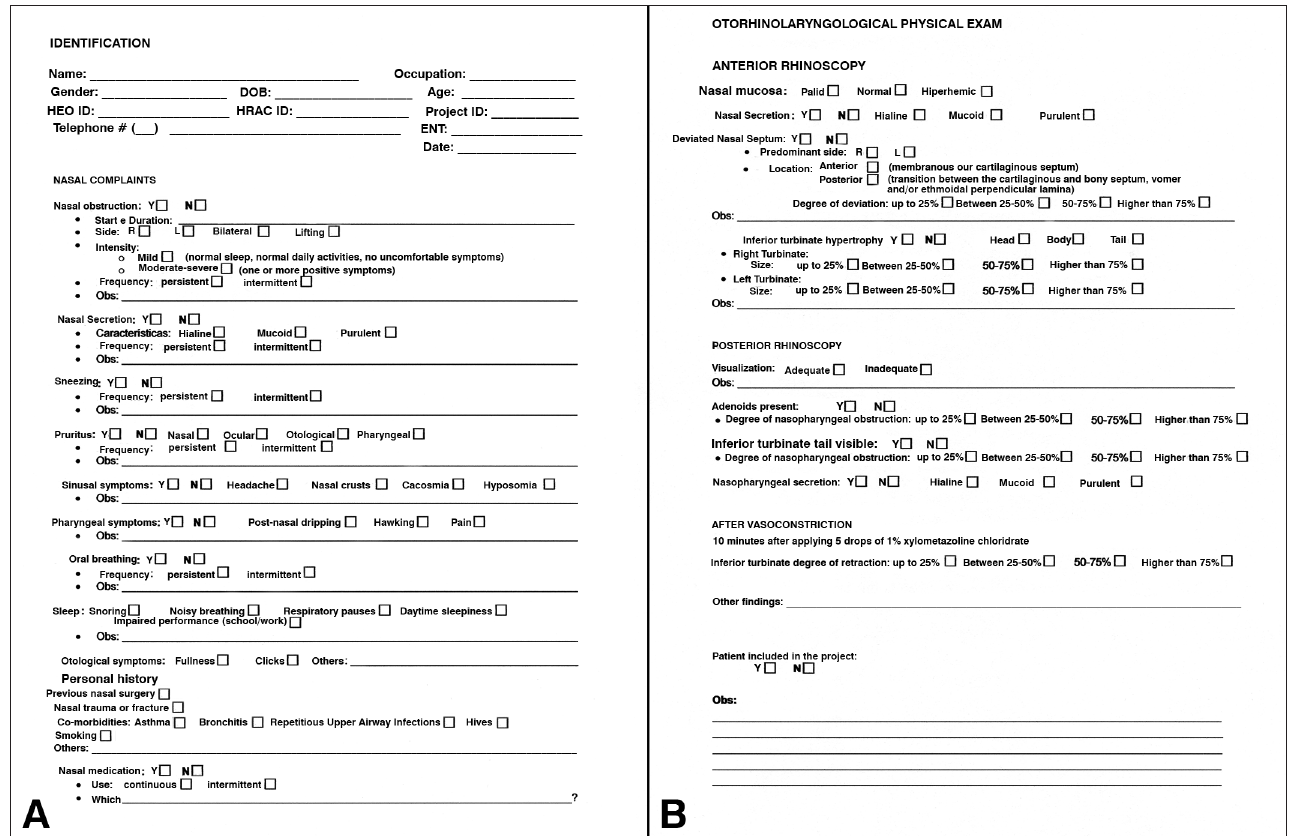
Figure 1. A: Interview protocol developed for this study; B: Physical ENT examination protocol developed for this